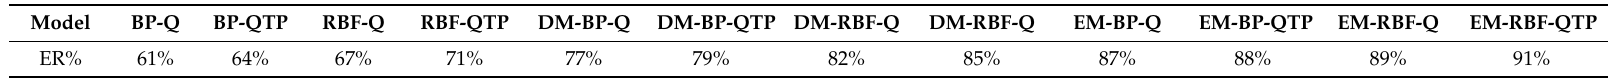
Table 13. An acceptable rate of forecasting for peak values during the flood season (May–October) for Zone Two. Model